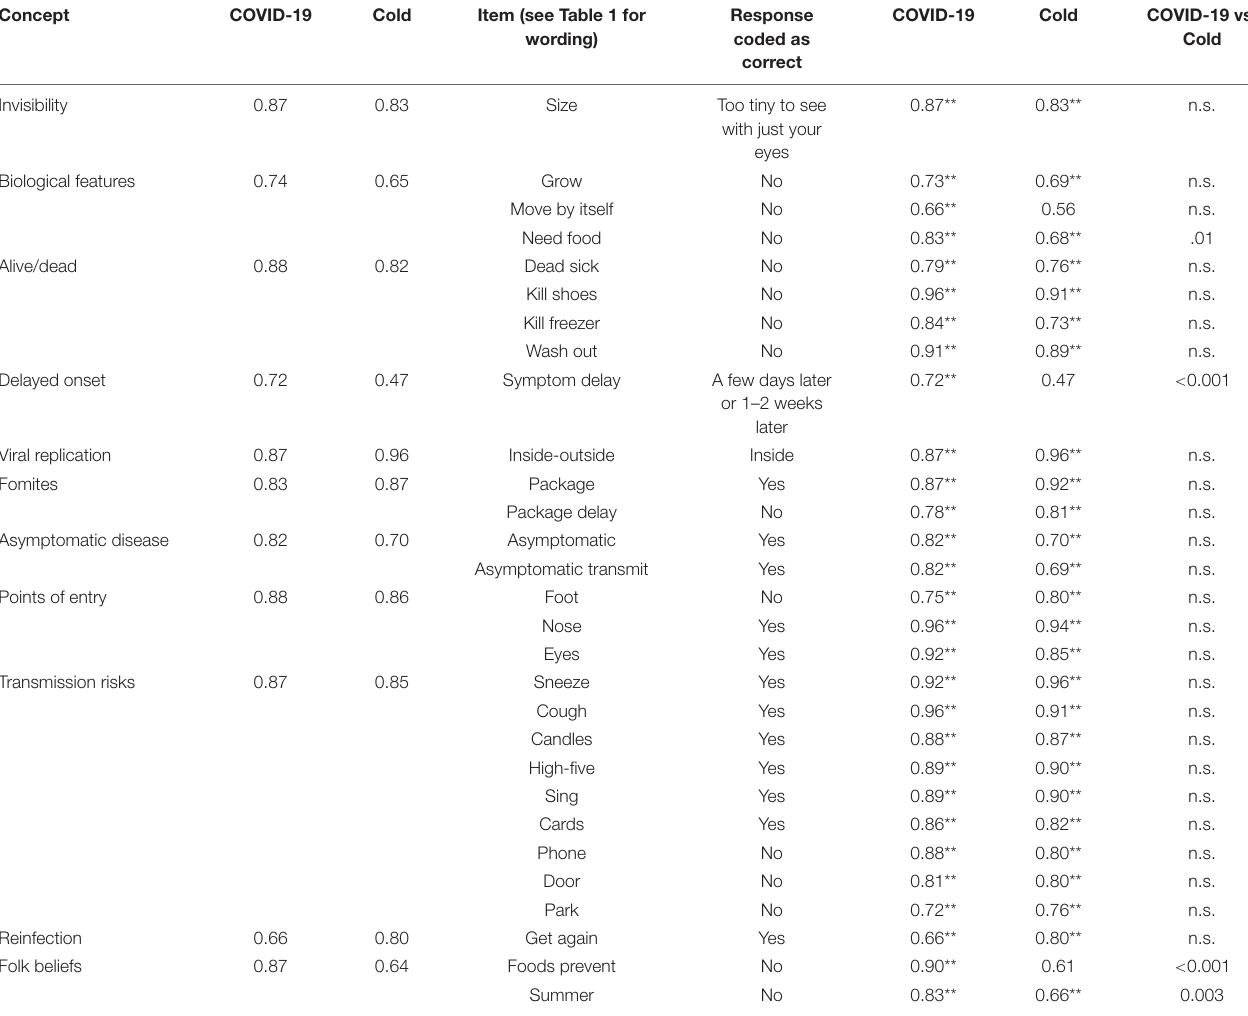
TABLE 3 | Accuracy composite, proportion correct per concept and item, as a function of condition (COVID-19 vs. cold). Concept